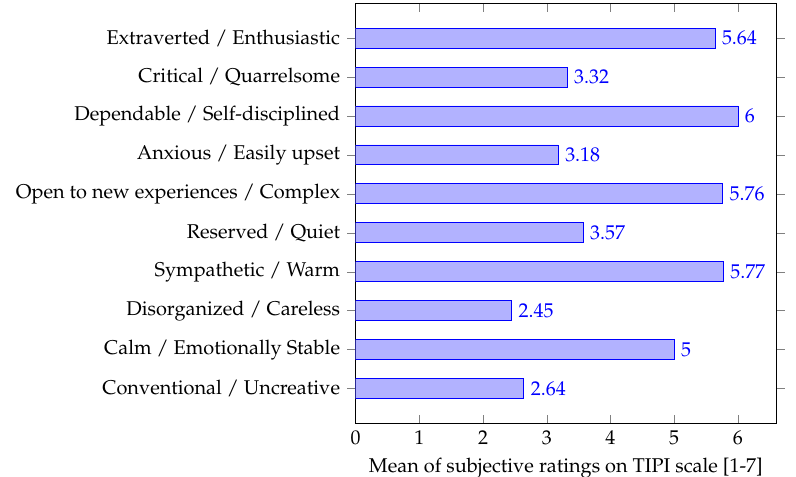
Figure 6. Twenty-two users rated how these personal traits applied to them according to Ten Item Personality Measure (TIPI) scale: strongly disagree (1), moderately disagree (2), disagree a little (3), neither agree nor disagree (4), agree a little (5), moderately agree (6), and strongly agree